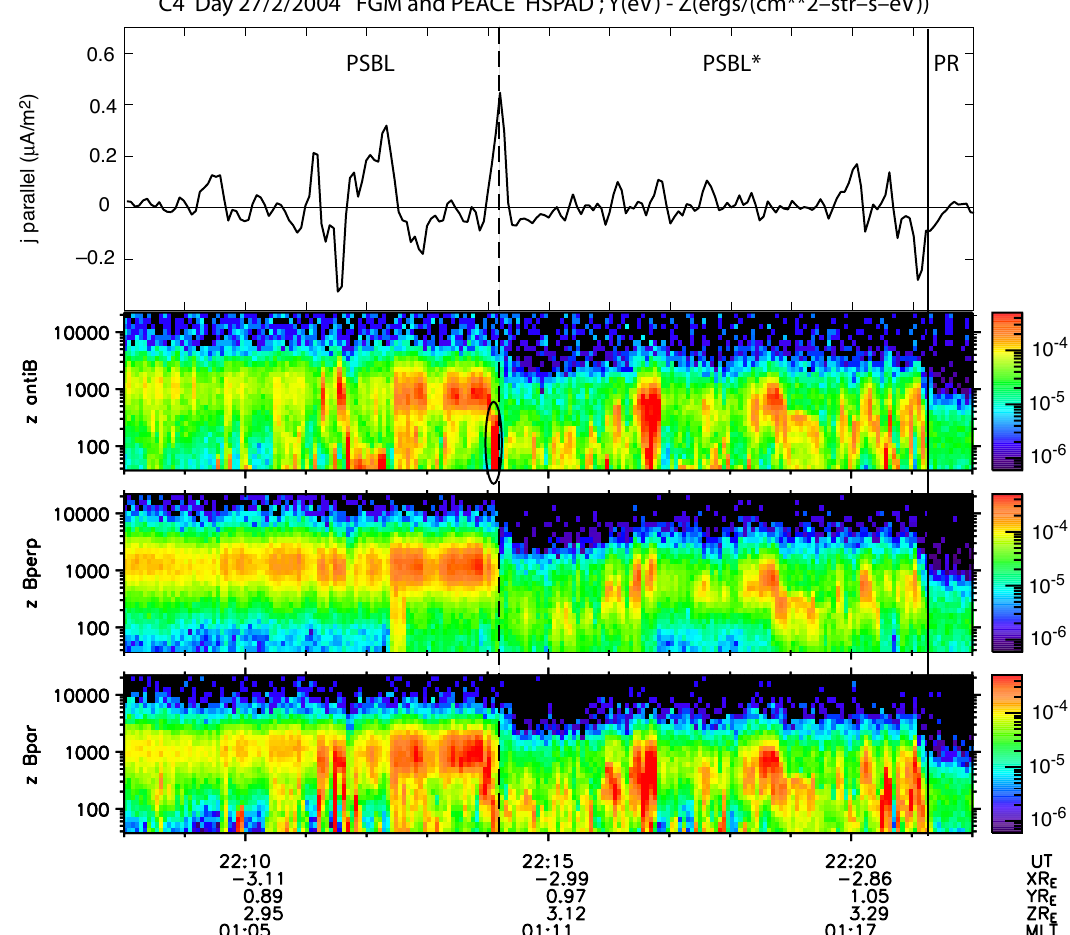
Fig. 13. Downward FAC for C4 (top panel) and PEACE data in the same format as Fig. 6 (bottom panels).